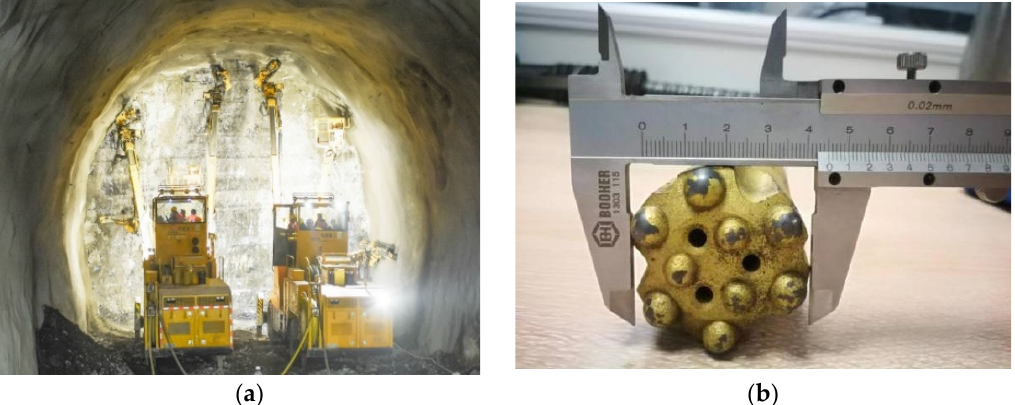
Figure 4. Field collection of the drilling parameters. ( a ) Blasting hole drilling in the tunnel face; ( b ) the cemented carbide bit.